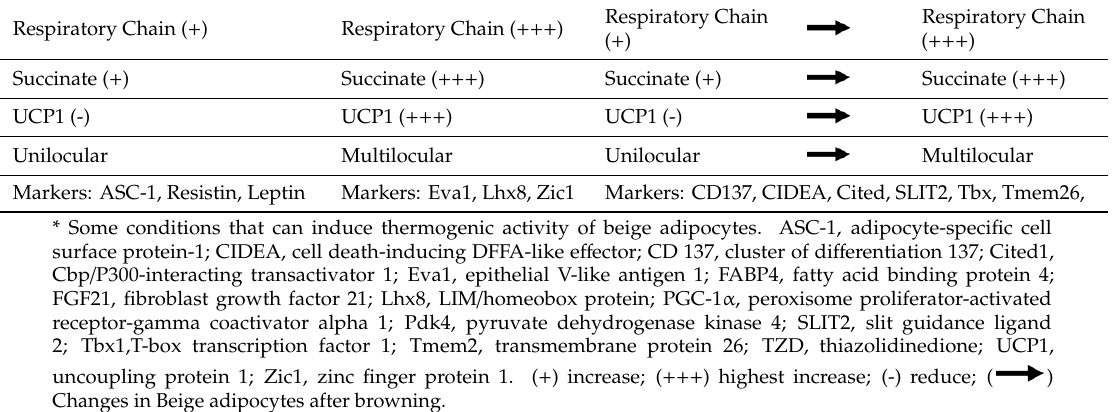
Table 1. Characteristics of different adipocyte tissues.